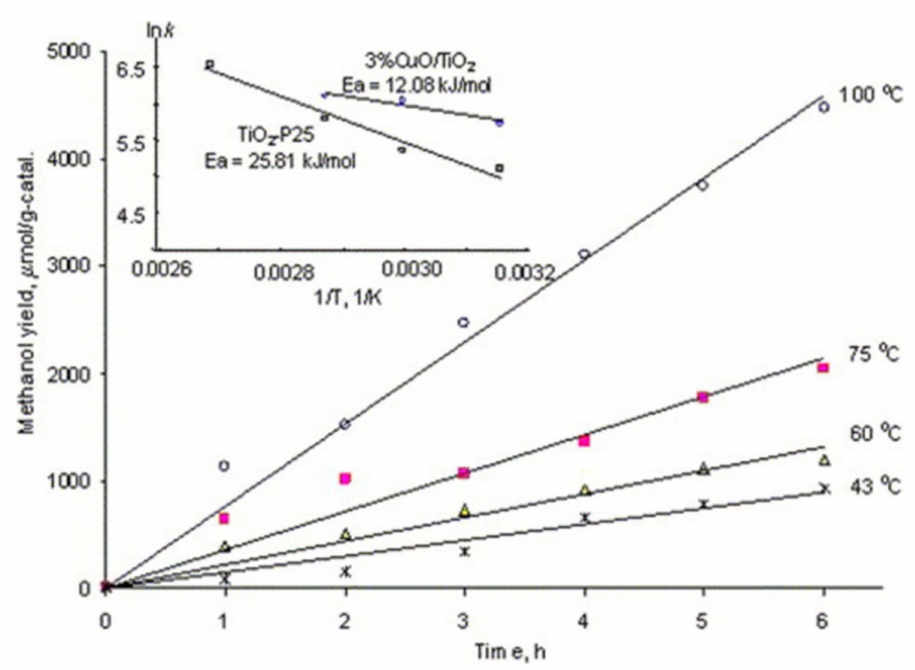
Figure 19. Temperature dependence of methanol production on TiO 2 , plot of TiO 2 , and 3% CuO/TiO 2 photocatalysts. Reprinted with permission from Elsevier, 19 December 2021 Ref.